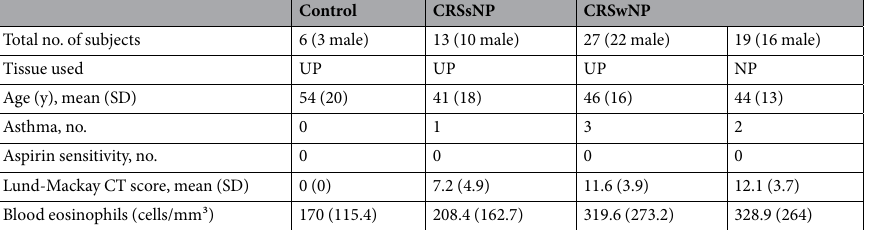
Table 1. Characteristics of study